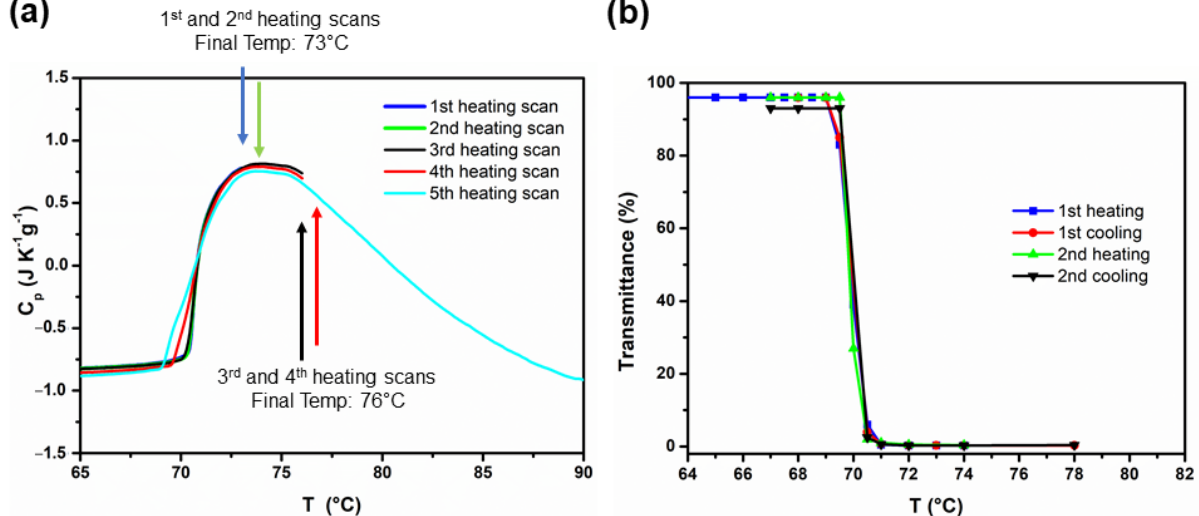
Figure 6. Reversibility of the aggregation process for pEFS8-26 aqueous solution studied by n-DSC (changing the final temperature by 3 °C every two heating scans) ( a ) and turbidity measurements ( b ).